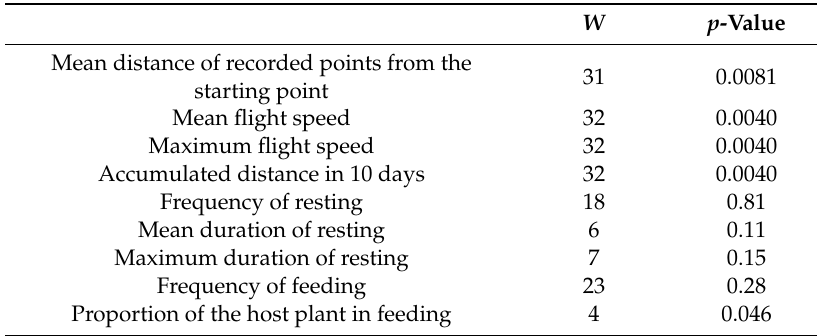
Table A3. Values of the U test between sexes in Z. m. okinawana.